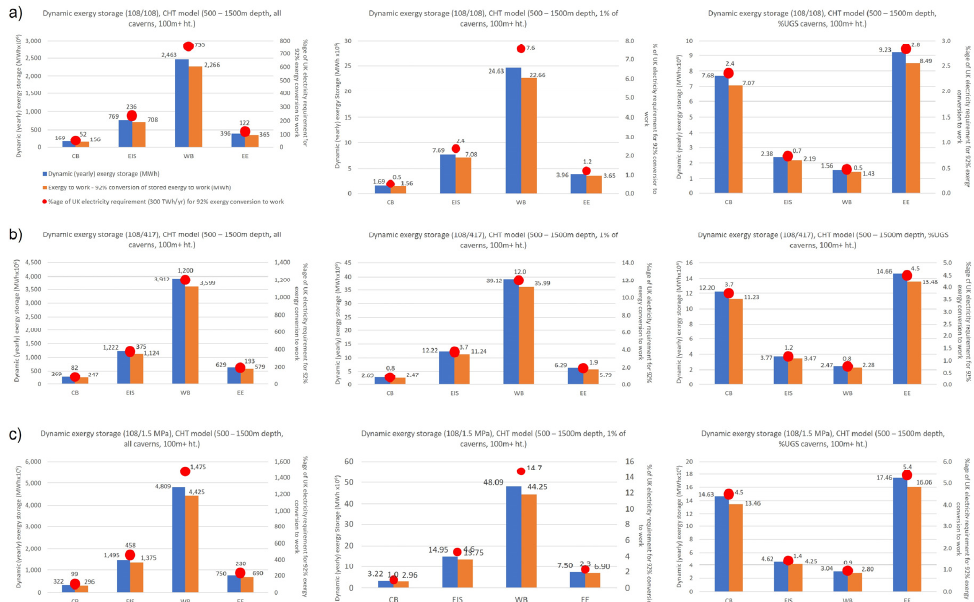
6 Figure 6. Plots of dynamic exergy storage and exergy to work estimates for the preferred CHT model over the depth range 500–1500 m and cavern heights 100 m+ considered for CAES. Parts ( a – c ) show graphs for differing injection/withdrawal rates (108/108 kg/s and 108/417 kg/s) or fill and pressure reduction rates (108 kg/s/1.5 MPa/h) for all potentially available caverns, 1% of available caverns, and estimates based upon the number of UGS caverns in the basins. Additionally shown, by basin, the percentage of UK electricity demand for 92% of stored exergy to work. Key common to all; see Figure 3. |||